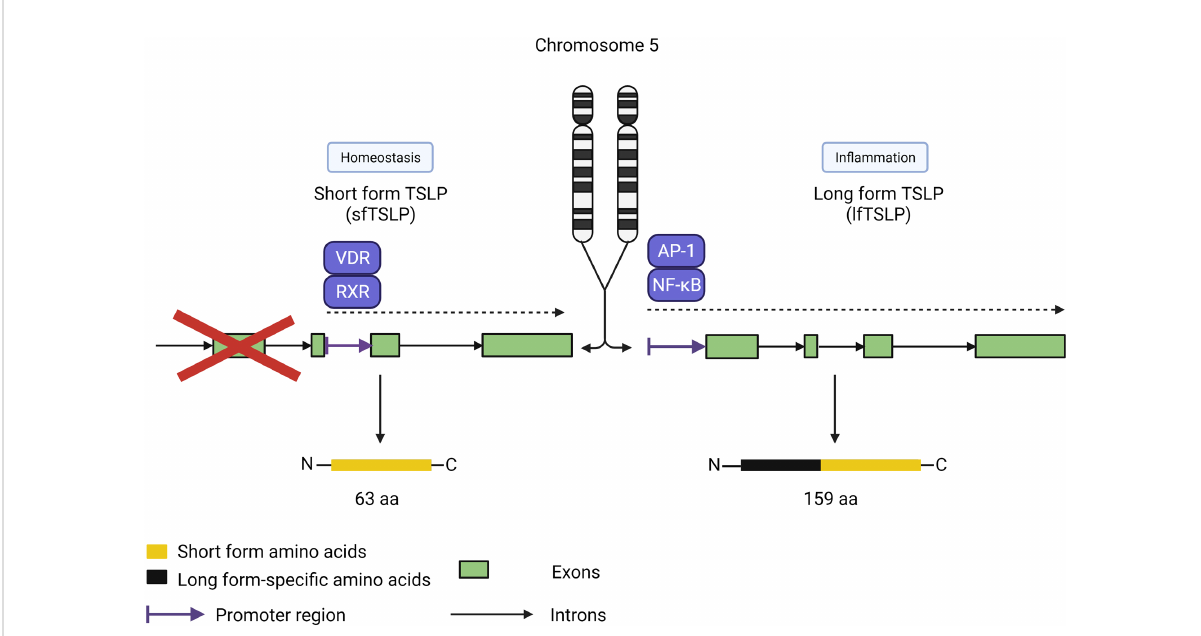
FIGURE 5 TSLP isoforms. TSLP has two isoforms covering two distinct roles: sfTSLP (63 amino acids) for homeostasis and lf TSLP (159 amino acids) for in fl ammatory responses. Each isoform is under the control of different promoter regions directed by distinct pathways, with the vitamin D receptor/retinoid X receptor pathway speci fi c for sfTSLP expression and the AP-1/NF-kB pathway for lfTSLP. Both isoforms share the same Cterminus amino acid sequence but have distinct N-terminus